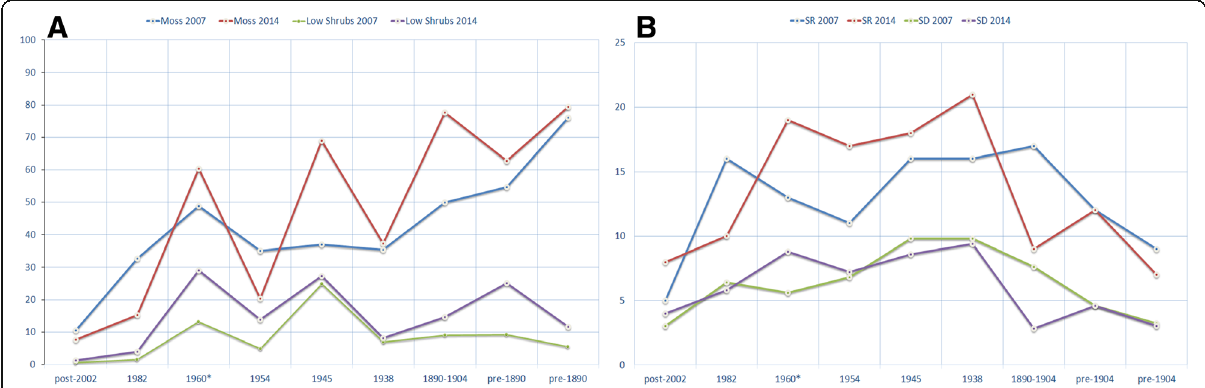
Fig. 3 Site-by-site comparisons of 2007 data to 2014 data with approximate dates of deglaciation for each site (see Fig. 1 and text for details); 1960* denotes that the age of this site (site F) differs significantly from the spatially adjacent sites. a Comparisons of moss and low shrub percent coverage. b Comparisons of SR (in number of species per site) and SD (species m − 2